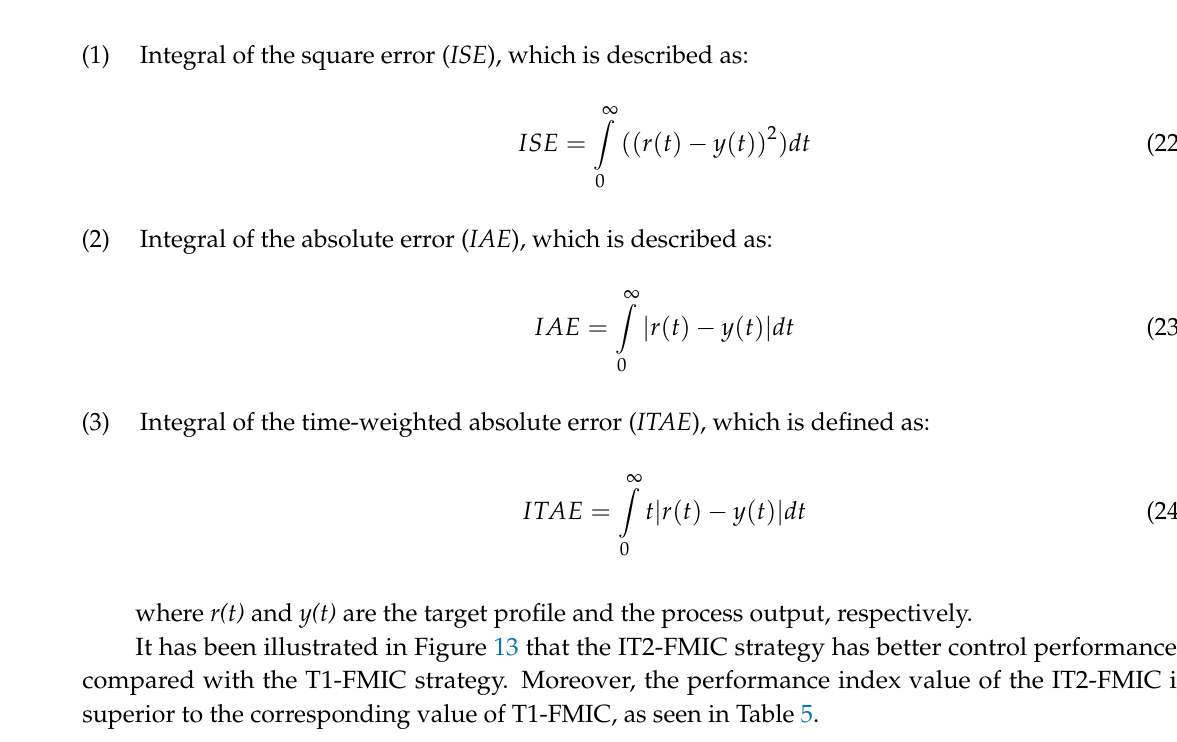
Table 5. Regulation performance comparison of the inverse controllers. ISE, integral of the square error; IAE, integral of the absolute error; ITAE, integral of the time-weighted absolute